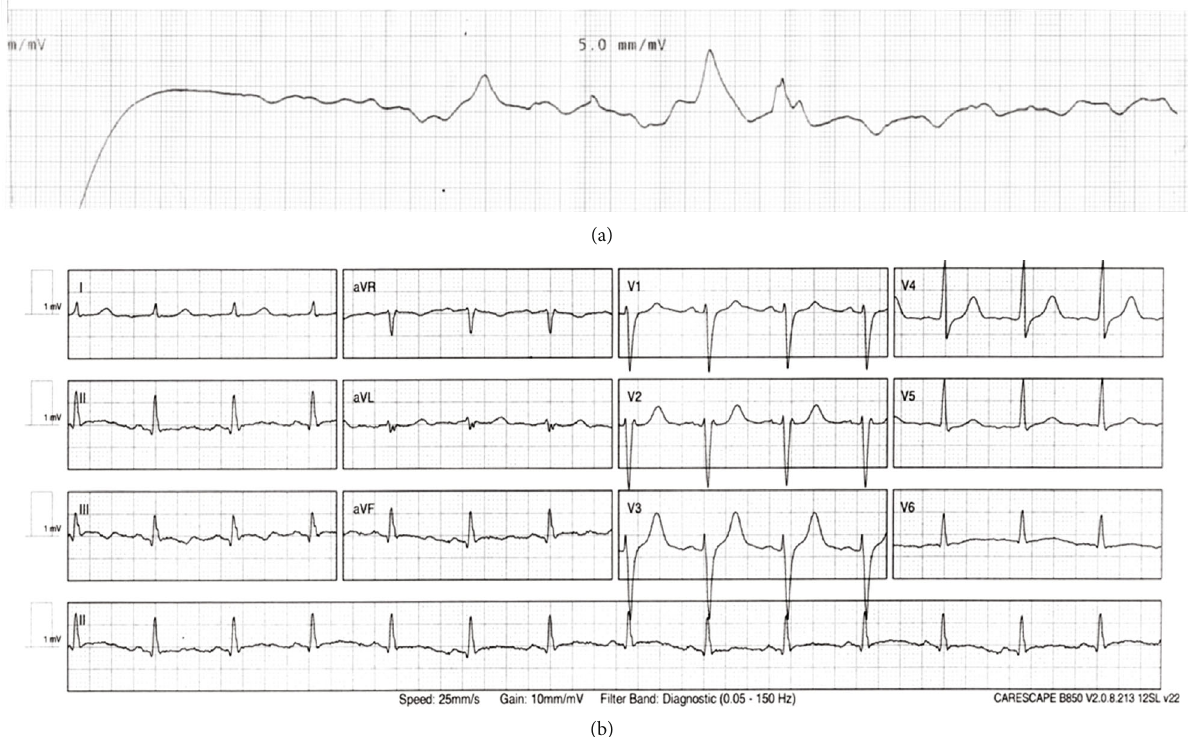
Figure 3: Extended pulse check followed by post-ROSC 12-lead ECG. (a) Rhythm strip with extended observation, demonstrating an intrinsic rhythm, identi fi ed complex with corresponding pulse shown with a red arrow. (b) 12-lead ECG of patient with sinus rhythm restored with a rate of